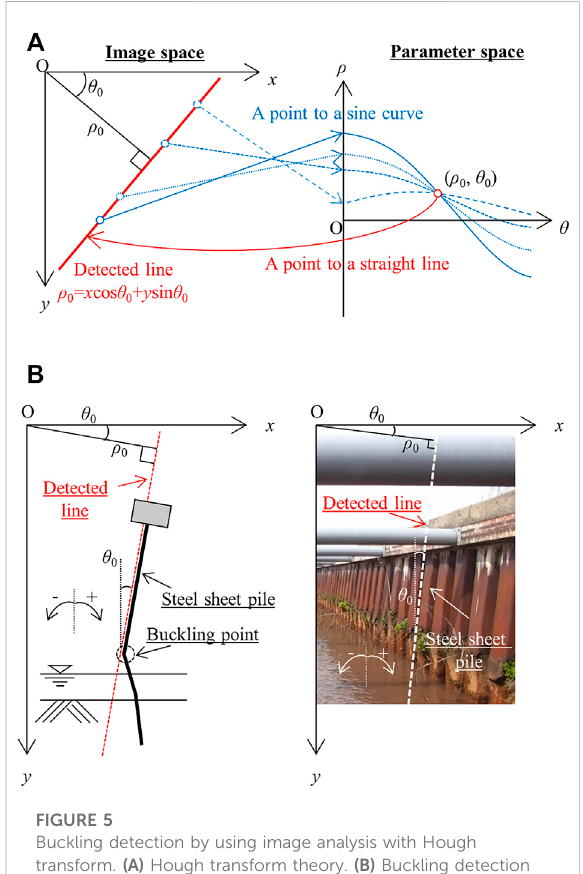
FIGURE 6 Correction of image rotation. (A) Projective transform for horizontally rotated image. (B) Image correction model by projective